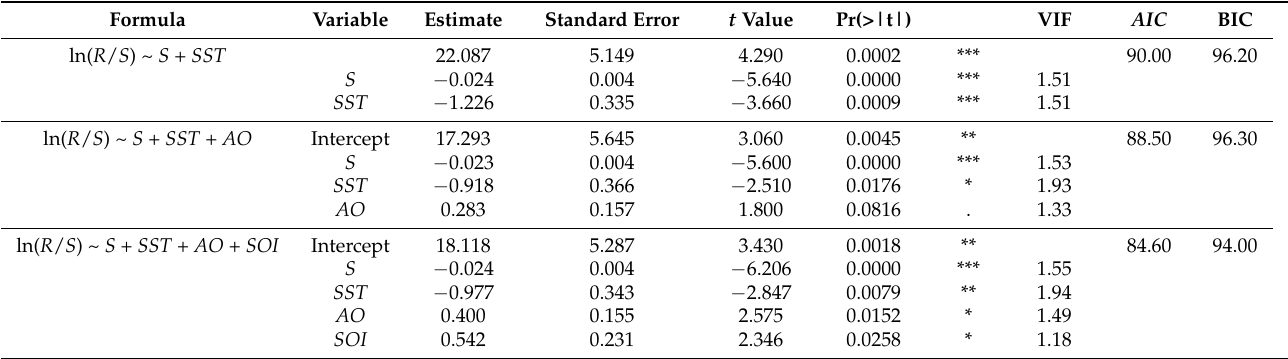
Table 2. Results of the best Ricker-E model with the addition of environmental factors in different numbers.